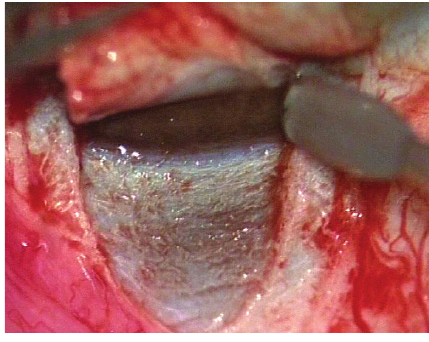
Figure 2: Deep scleral flap.